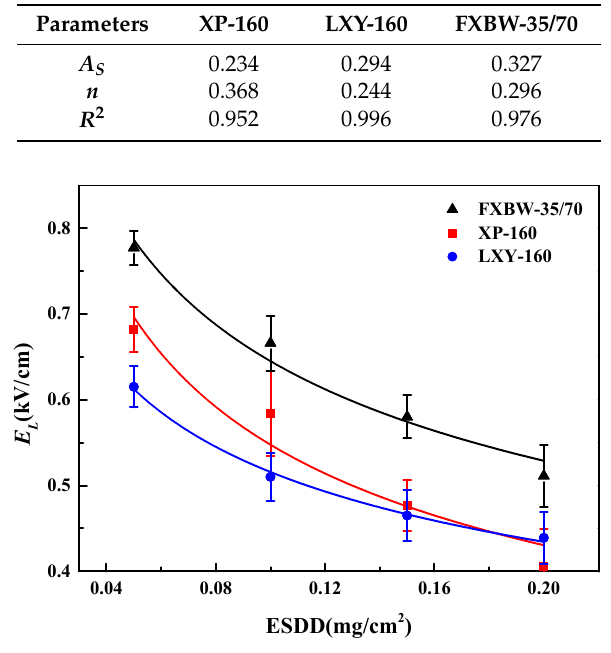
Table 3. Fitting values of A s , n and R 2 according to the test results in Table 2 with Equation (4).